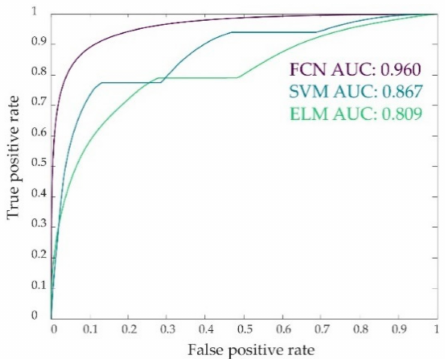
Figure 7. Receiver operating characteristic (ROC) curves for the aggregated data, showing the relationship between true-positive and false-positive rates estimated by the three models compared to the ground truth.